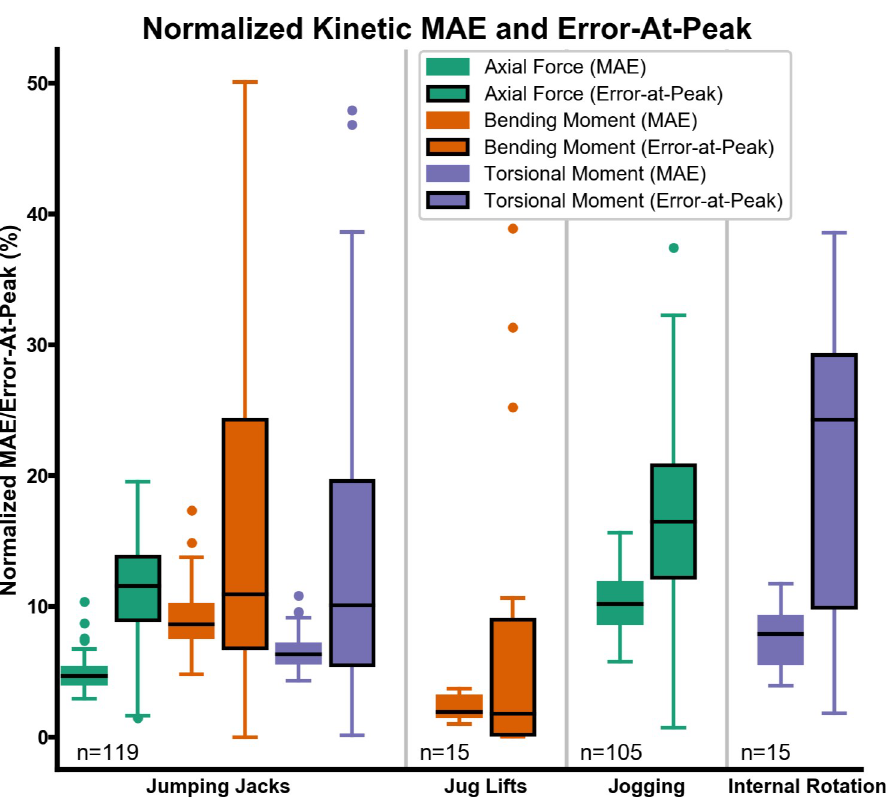
Fig 7. Boxplots of normalized kinetic MAE and error-at-peak. The relevant kinetic variables are grouped by activity. Error-at-peak is represented by a solid line around the box.